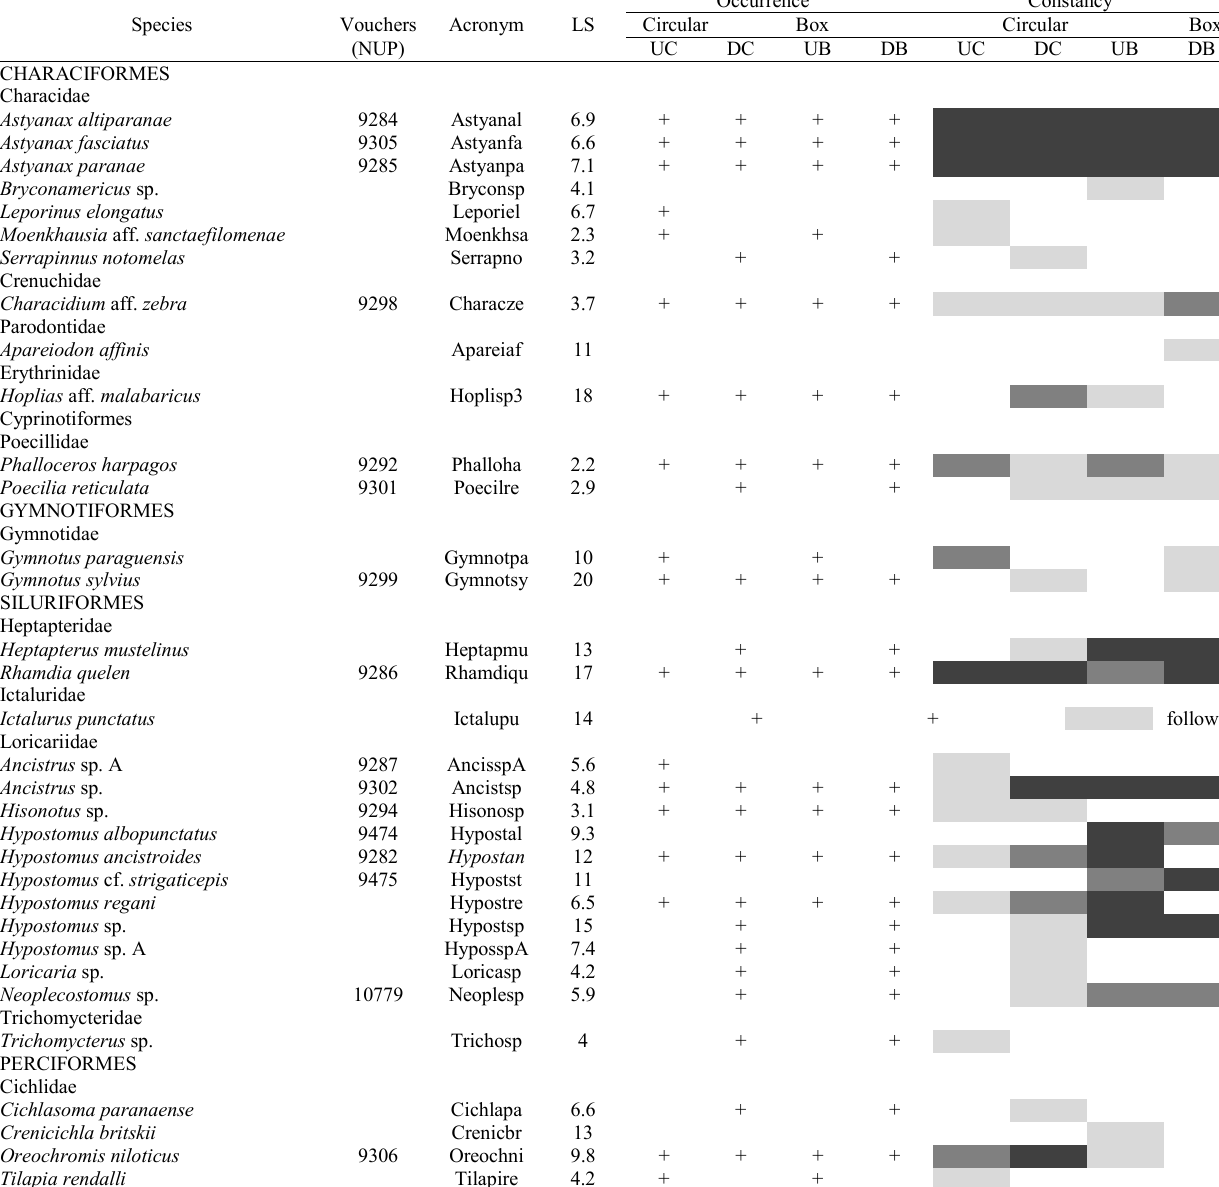
Table 2. Fish species collected in the stretches of Lopeí (Upstream Circular Culvert - UC, Downstream Circular Culvert - DC) and Pindorama (Upstream Box Culvert - UB, Downstream Box Culvert - DB) streams. SL = mean standard length of fish species (SL) (cm). Rating scales of constancy in color: dark gray (constant), gray (accessory), light gray (accidental), and